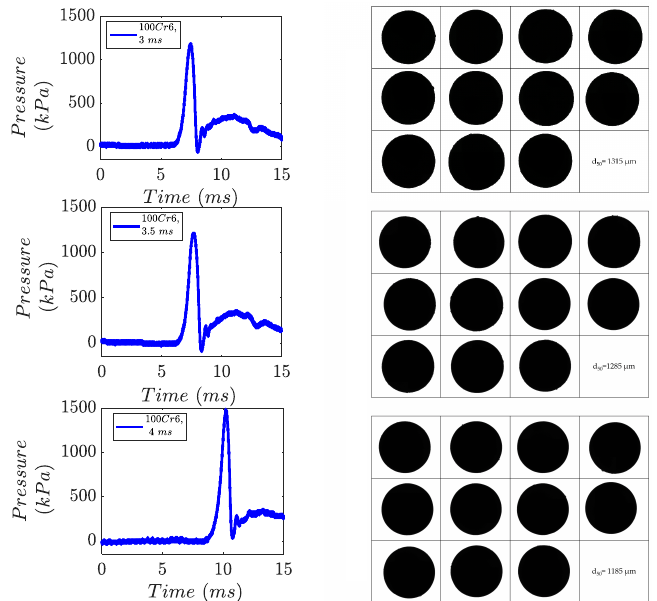
Figure 7. Pressure wave measurements during the experiments with EN 1.3505 and valve opening times of 3, 3.5 and 4 ms and corresponding particle images from image